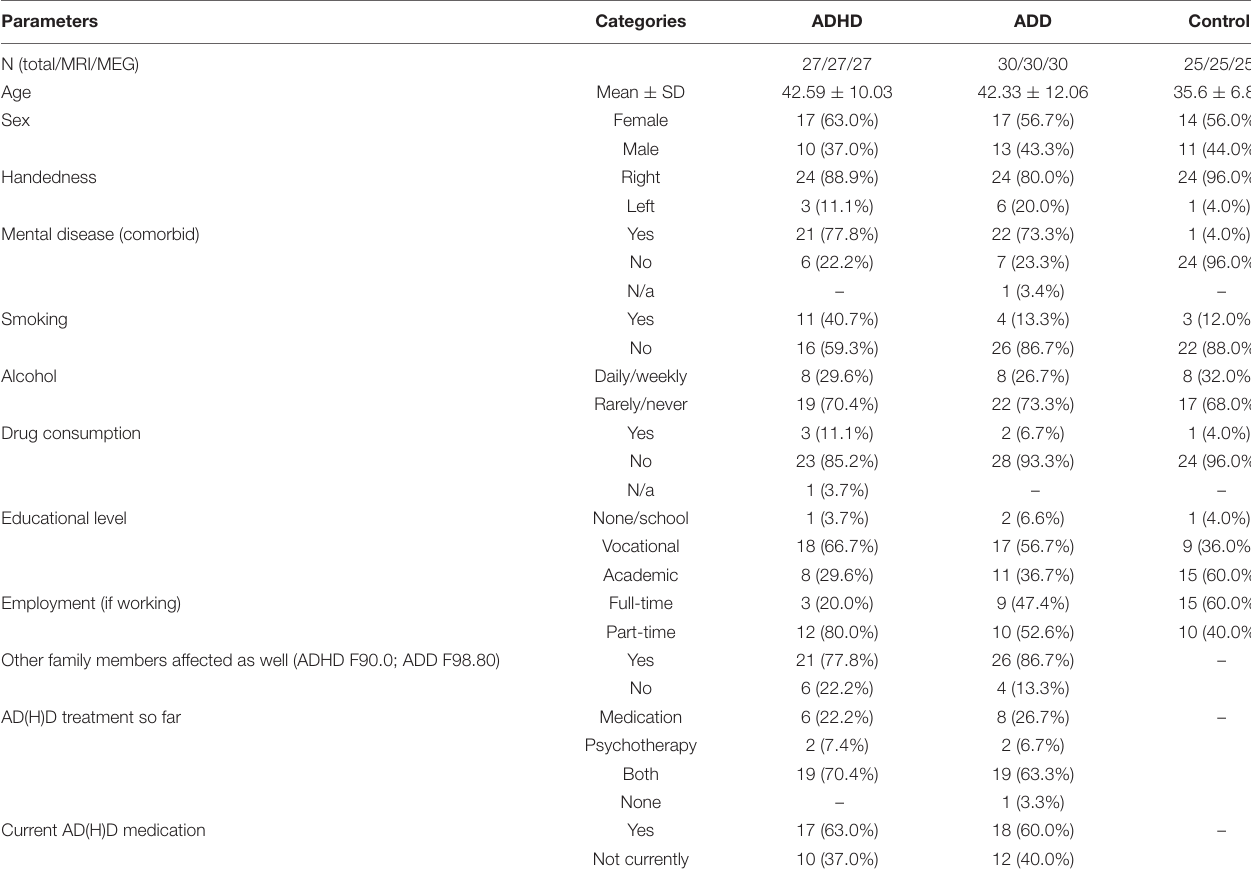
TABLE 1 | Description of